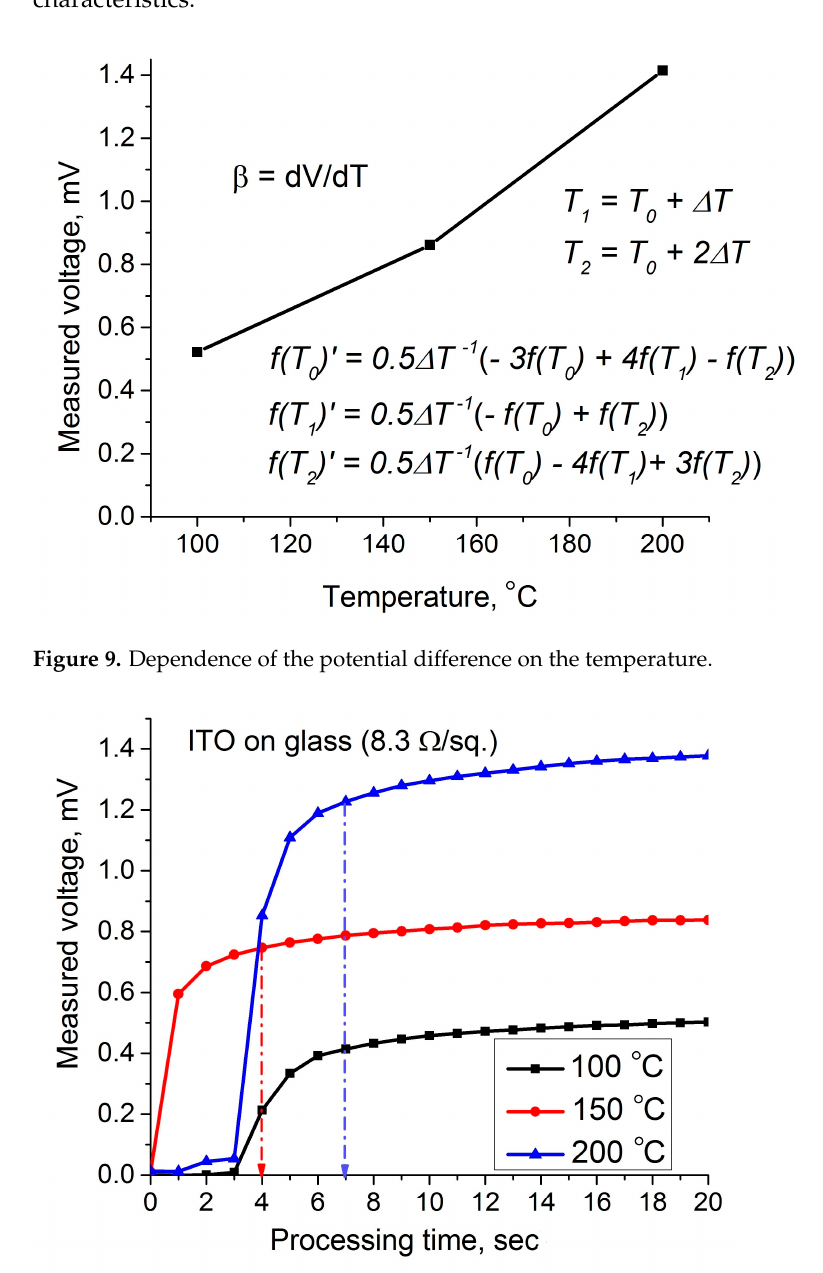
Figure 10. Extraction of saturation parameters, voltage and current, from recorded dynamic hot- probe characteristics.